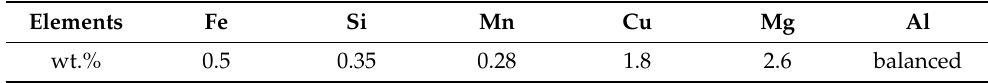
Table 1. Chemical composition of 2218AlA substrate.